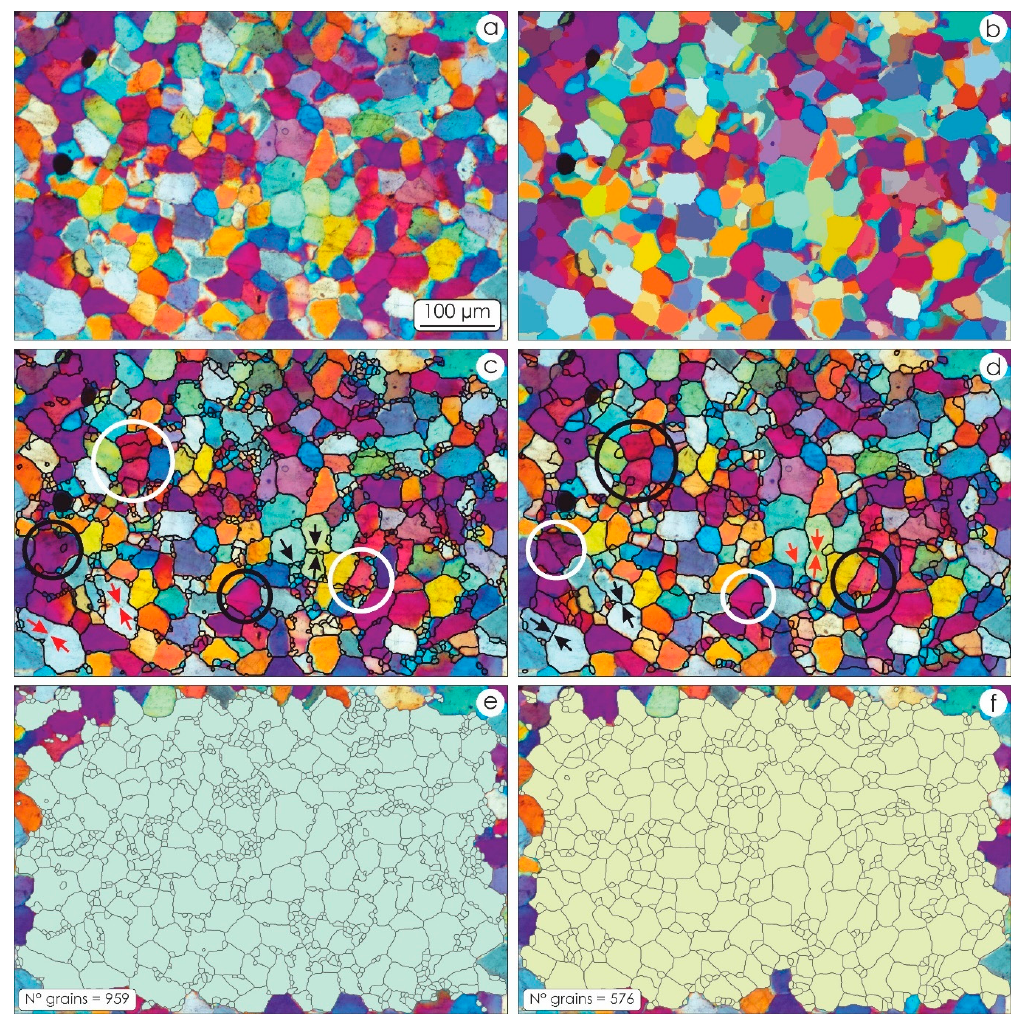
Figure 11. Comparison between results obtained by the Thin Section GIS (TSG) tool of [4] ( a , c , e ) and the Micro-Fabric Analyzer (MFA) ( b , d , f ): ( a ) thin section input image. Width of field is 1 mm; ( b ) output of the Segment Mean Shift algorithm; ( c , d ) TSG ( c ) and MFA ( d ) grain boundary detection. Both tools show the effect of over- (white circles) and under-segmentation (red arrows). Black circles and arrows show more performing results on the same locations of one tool if compared with respect to the other one.